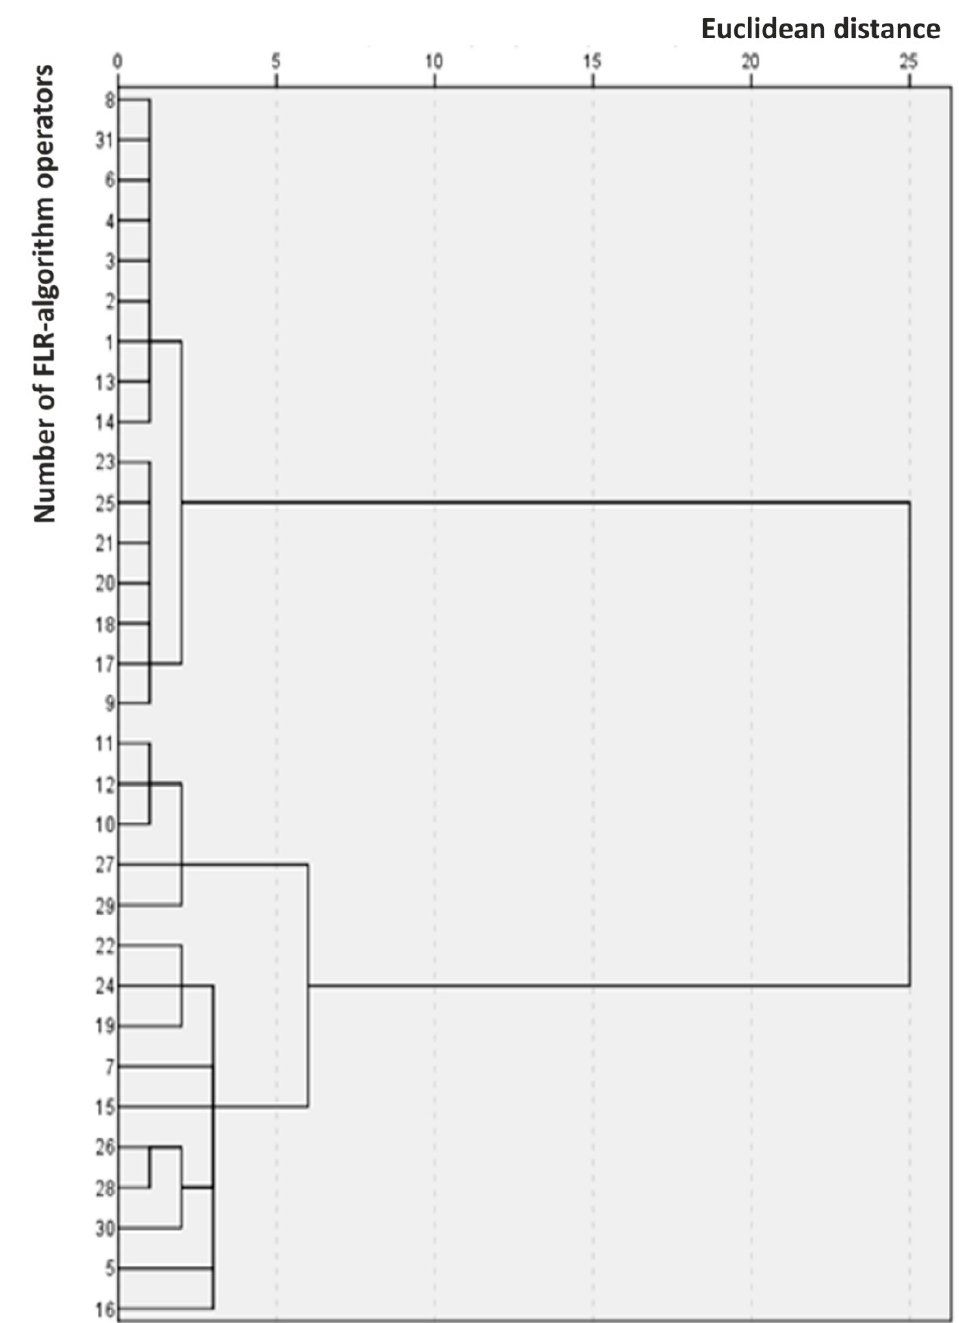
Figure 6. Ward’s dendrogram for the FLR algorithm.